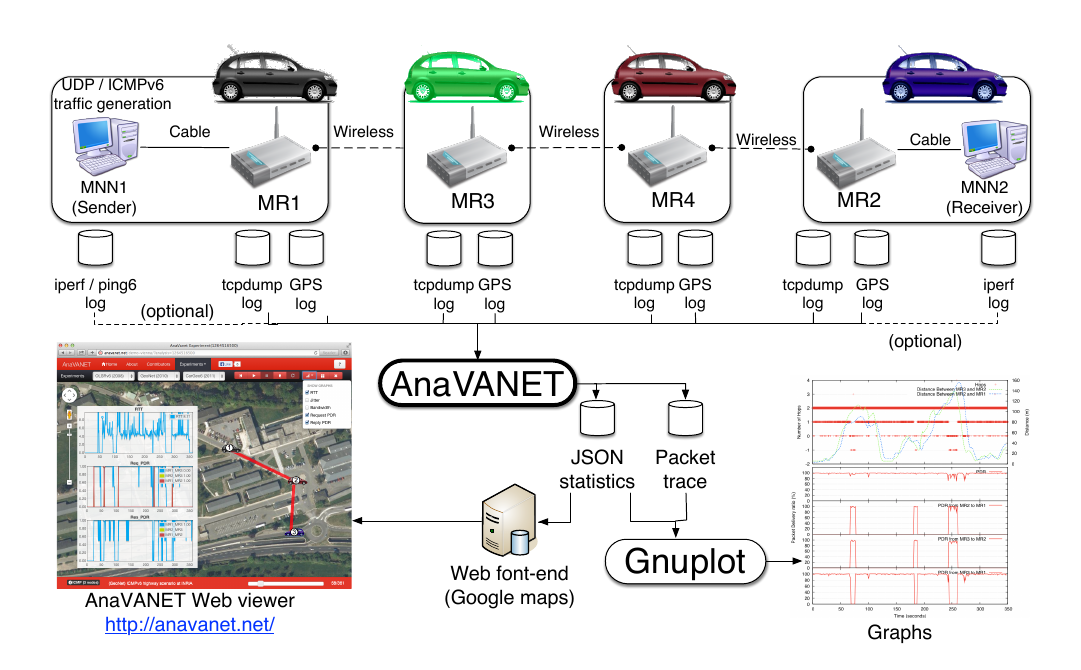
Figure 7. Overview of AnaVANET